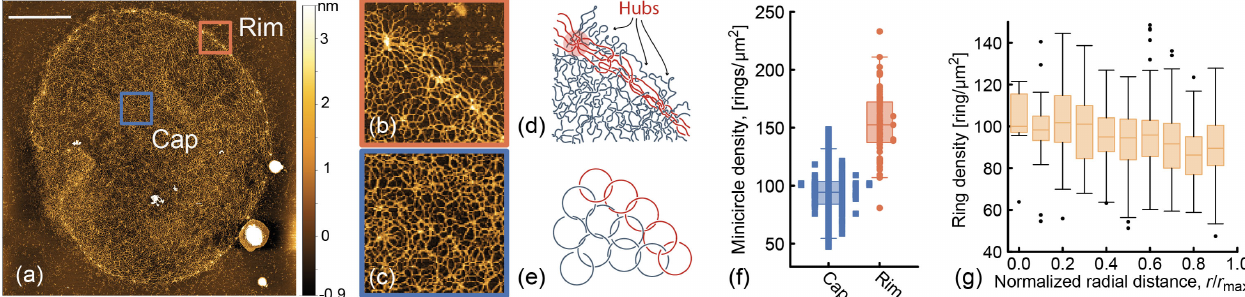
FIG. 1. (a) AFM images of kDNA from C. fasciculata . The scale bar is 2 μ m, and the yellow color scale ranges from 0 (black) to 3.5 nm height (white). (b),(c) Enlargements of the rim and cap, respectively. (d) Sketch of the network of minicircles from (b) where we color code the minicircles forming the rim in red. (e) Simplified sketch where we schematically show that the network is formed by linked rings. This is not a one-to-one representation of (d). (f) Box plot of minicircle density in the cap and the rim of the network (obtained from selected regions and averaged across three kDNA networks). The rim density is computed by taking a circular region of radius r ¼ 100 nm (about the size of a minicircle; see below) centered at the hubs. (g) Box plots of the density of minicircles as a function of the distance from the